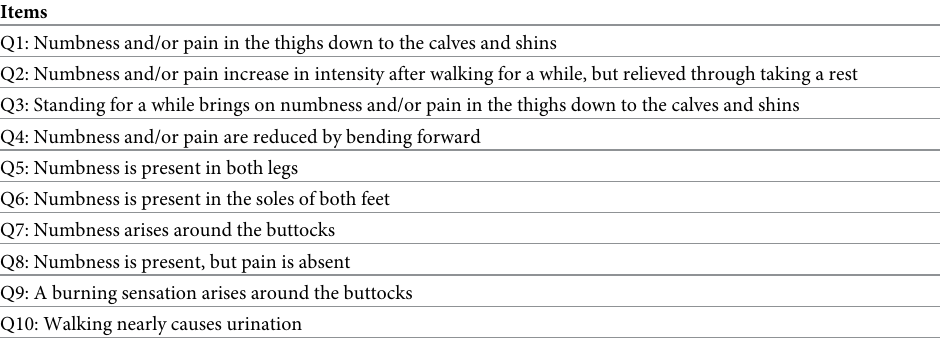
Table 2. A self-administered, self-reported history questionnaire for identifying patients with LSS